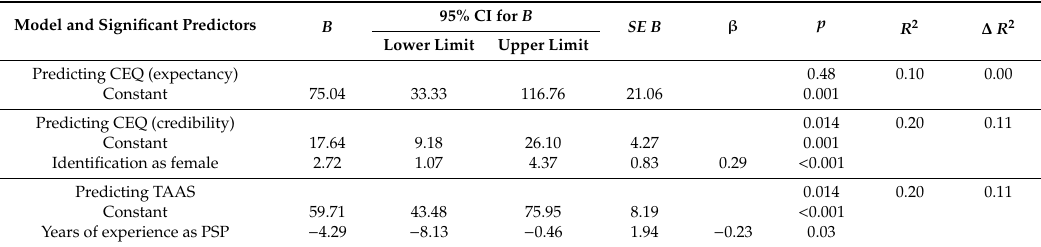
Table 3. Summary of regression models and statistically significant predictors. Model and Significant Predictors B 95% CI for B Predicting CEQ